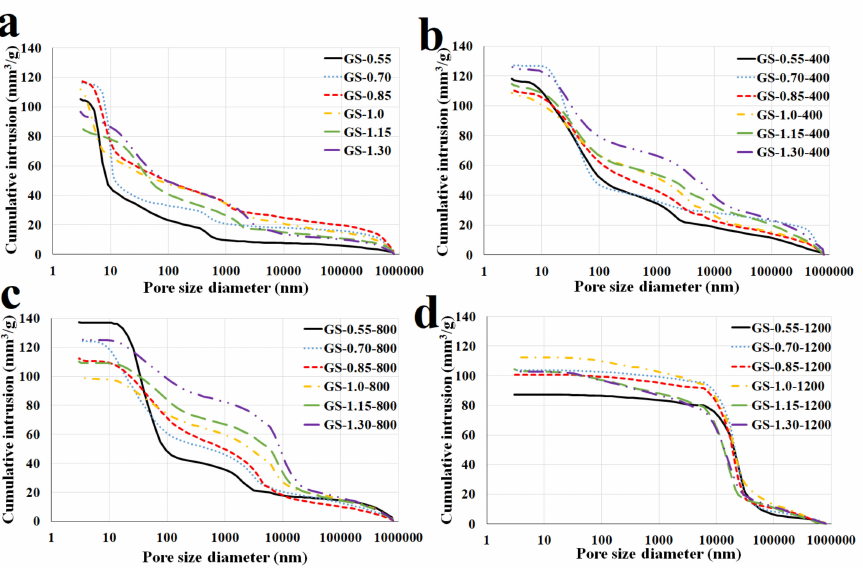
Figure 9. Mercury intrusion porosimetry of the geopolymer composites with various molar ratios of K/Al at laboratory temperature ( a ) and after exposure to 400 ◦ C ( b ), 800 ◦ C ( c ), and 1200 ◦ C ( d ). As shown in Figures 9 and 10, from laboratory temperature (25 ◦ C) to 800 ◦ C, with the increasing of K/Al, the pore size more or less increased, while from 1000 ◦ C to 1200 ◦ C, the pore size drastically decreased with higher molar ratios. A large decrease occurred in the sample GS-1.0. Samples GS-0.55, GS-0.70, and GS-0.85 had values of average pore size 10, 14, and 15 nm after hardening at laboratory temperature and 2172, 2570, and 2145 nm after exposure to 1200 ◦ C. On the contrary, samples GS-1.0, GS-1.15, and GS-1.30 had values of average pore size 11, 27, and 26 nm after hardening at laboratory temperature and 485, 170, and 206 nm after exposure to 1200 ◦ C. The effect of K/Al on pore volume was not significant. Pore volume of all samples ranged from 90 to 120 mm 3 /g. Rovnan í k et al. [1] investigated the porosity of matekaolin-based geopolymer composite filled with chamotte before and after exposure to high temperatures. They found out that values of pore volume were 120 mm 3 /g after exposure to high temperatures (up to 1000 ◦ C).